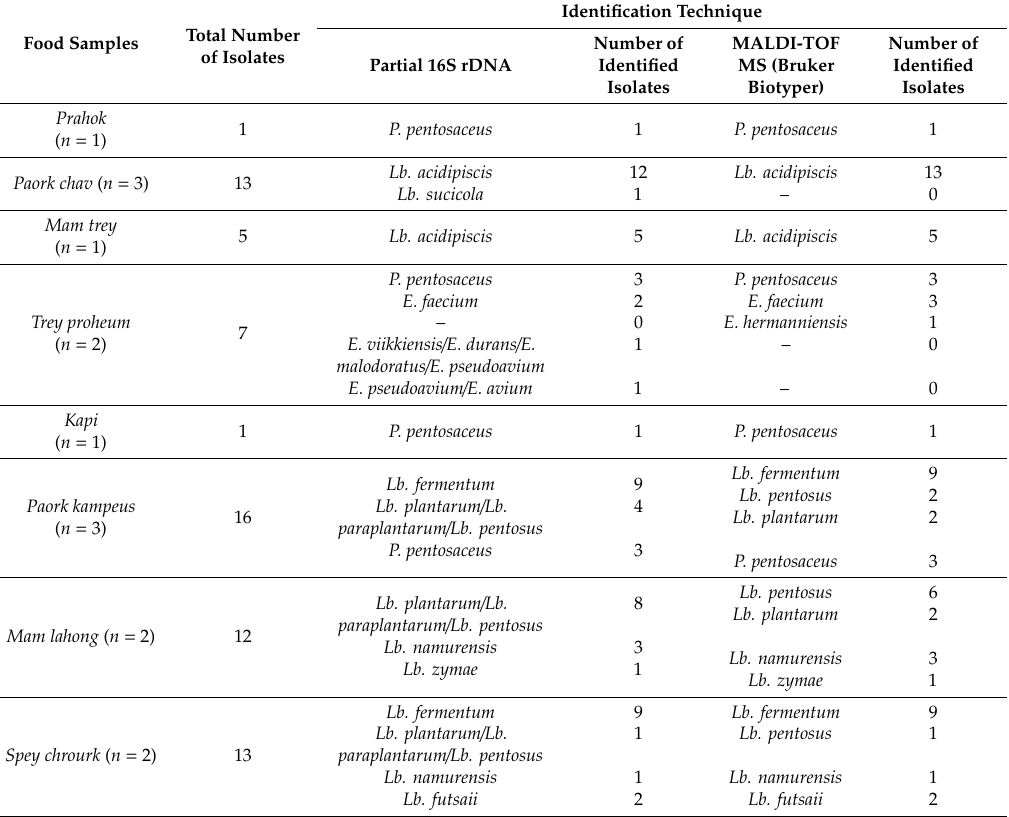
Table 2. Identification of LAB from di ff erent fermented foods by partial 16S rDNA sequencing and MALDI-TOF